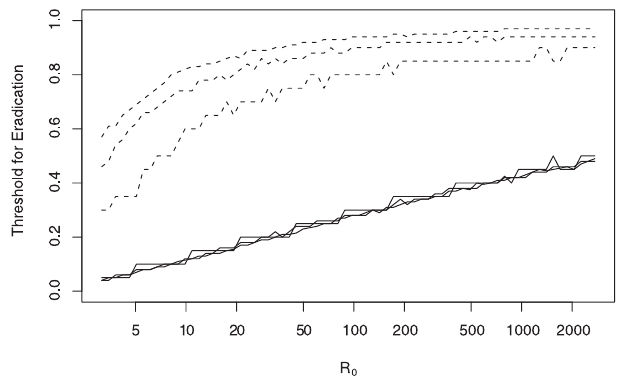
Figure 6. Achieving Herd Immunity with Random and Targeted Intervention This figure shows the relationship between R 0 and the proportion of a population that must be neutralized through chemoprophylaxis or a vaccine if the intervention is perfectly targeted (solid lines) or random (dashed lines), such that R 0 , 1. As the population size increases (from 20 to 50 to 100), the proportion that must be vaccinated increases for random intervention, but not for intervention targeted towards those bitten most.